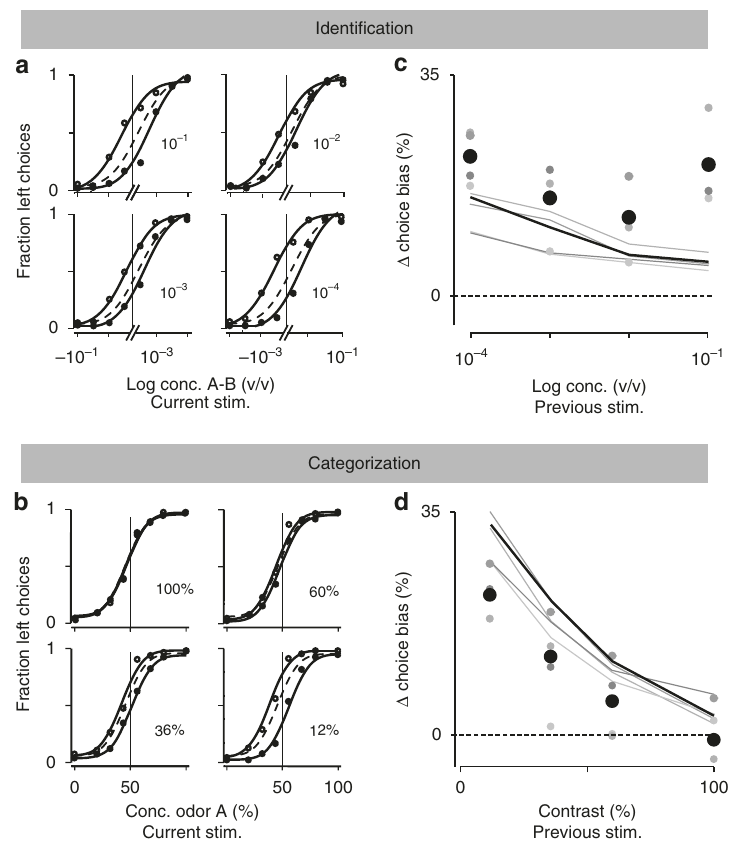
Fig. 6 Bayes-DDM predicts trial-by-trial change of choice bias after a rewarded trial and given stimulus. a , b Psychometric functions for mean (dashed line) and conditional curves following a reward, side choice and a given stimuli. For the identi fi cation task all four stimuli from 10 − 1 to 10 − 4 are depicted ( a ). For the categorization task from 12 to 100% mixture contrast ( b ). Filled-in circles and equivalent lines represent trials following a right-reward (B > A) and open circles, trials following a left-reward (A > B). Lines represent fi ts of a cumulative Gaussian to the data (Methods). c , d Change in choice bias plotted as a function of the previous stimuli, for plots in a and b . All four different odor concentrations for identi fi cation task ( c ); and all mixture sets for categorization ( d ). Points correspond to behavioral data (left side), and solid lines to the predicted change from the model fi tted to Fig. 5 (right side). Black points and line correspond to the obtained measurements considering all data together and predicted size of effect when Bayes-DDM fi ts chrono- and psychometric curves for both tasks. Depicted is also each one of the four rats as points with a different shades of gray, with their analogous model predictions (gray